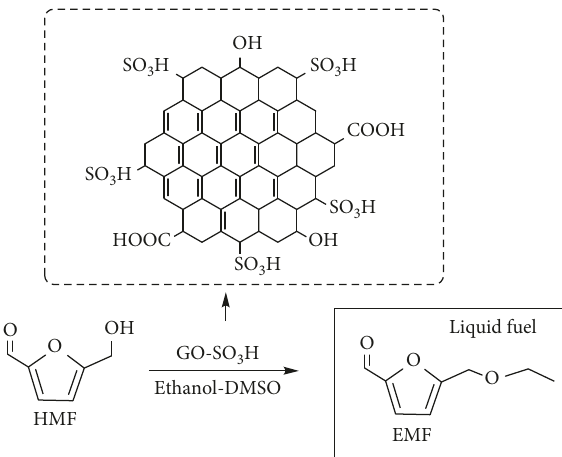
Figure 2: The conversion of HMF to EMF catalyzed by GO-SO